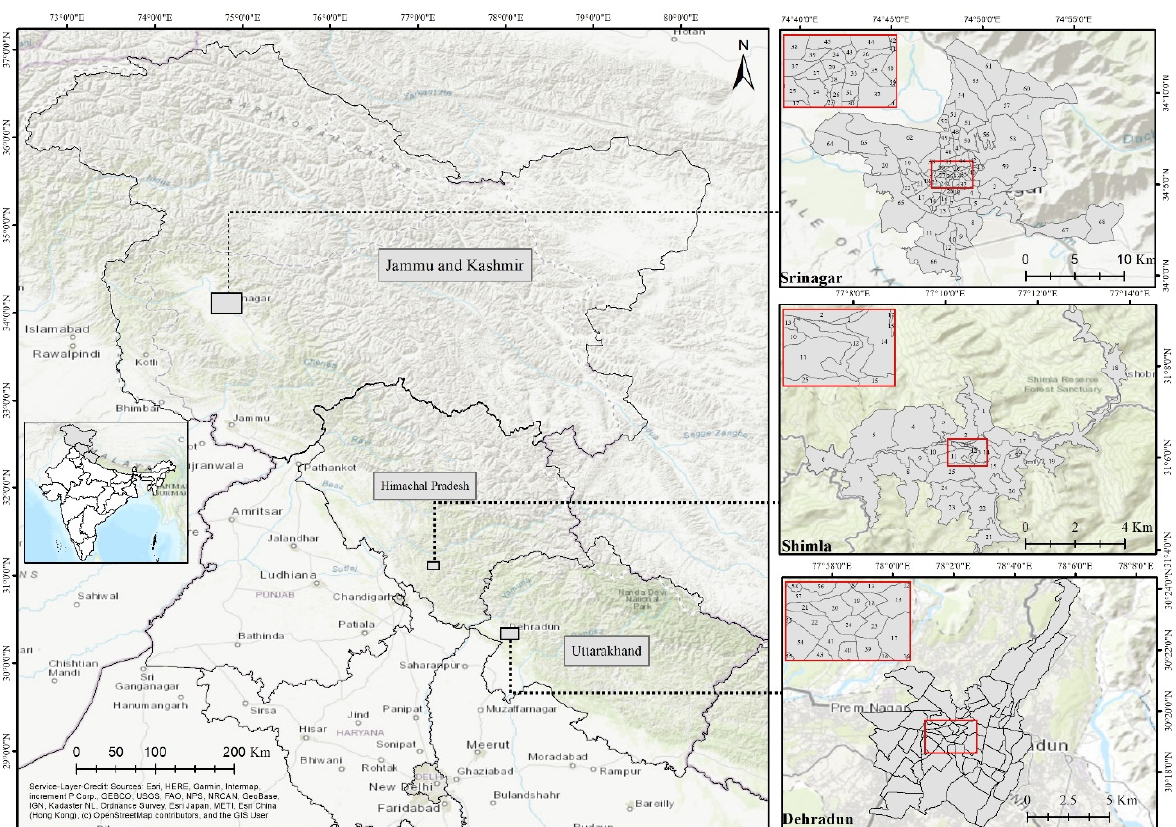
Figure 1. Location of capital cities of states in Indian Himalaya. The inset provides the ward boundary of these cities.